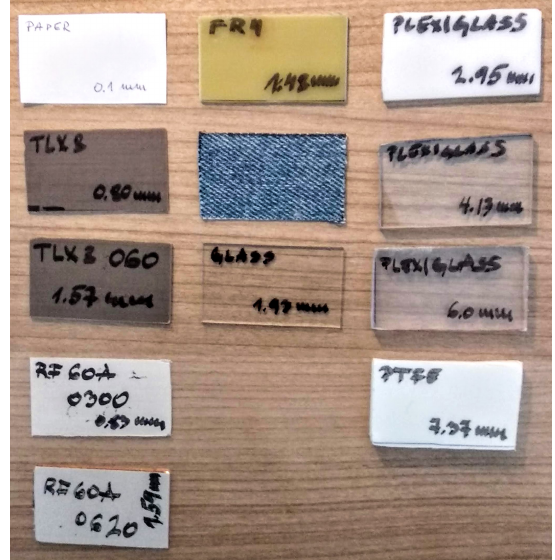
Figure 9. Dielectric materials that were